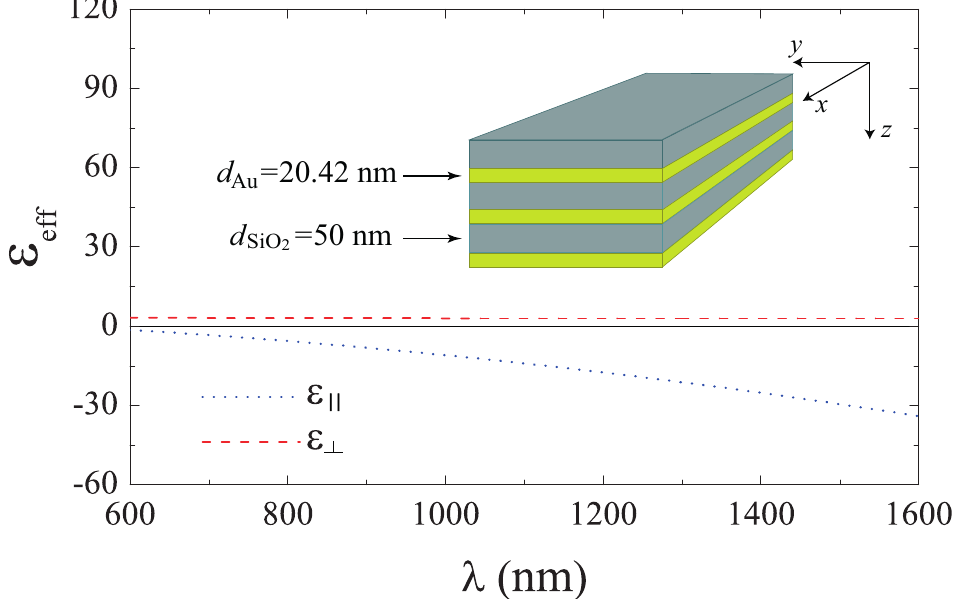
Figure 1. Real parts of ε (cid:107) and ε ⊥ for a semi-infinite multilayer built by alternate SiO 2 and Au layers. The layer thicknesses were used as d m = 20.42 nm and d d = 50 nm for Au and SiO 2 , respectively. A schematic representation of the system under study is shown in the inset.